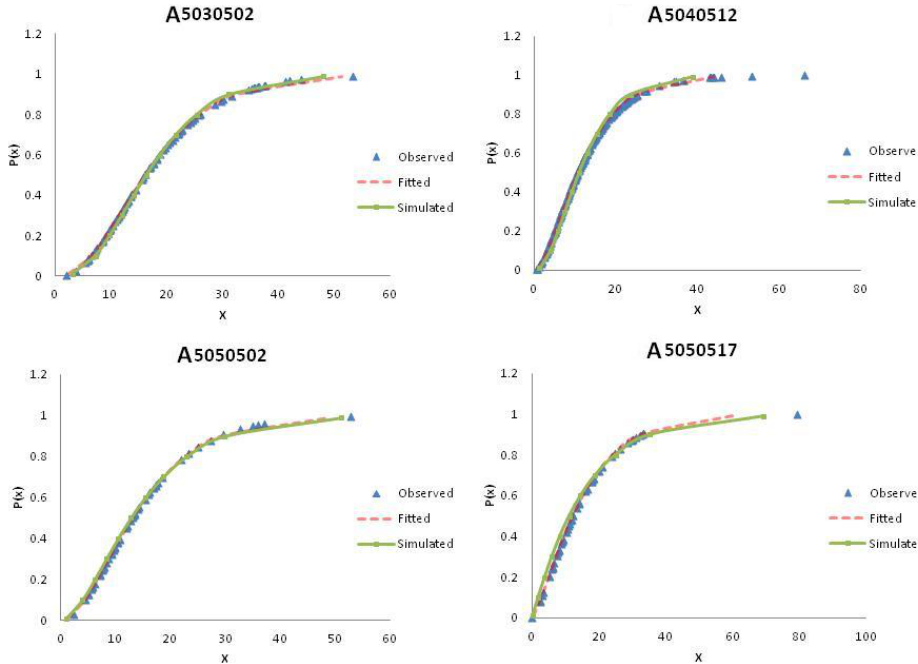
Fig. 4. Probability plots of the study